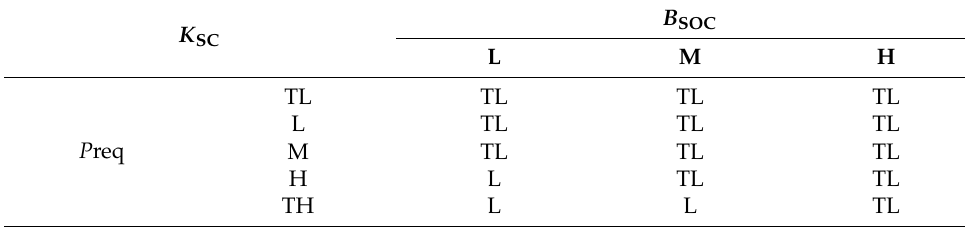
Table 3. Fuzzy control rules ( S SOC = L).